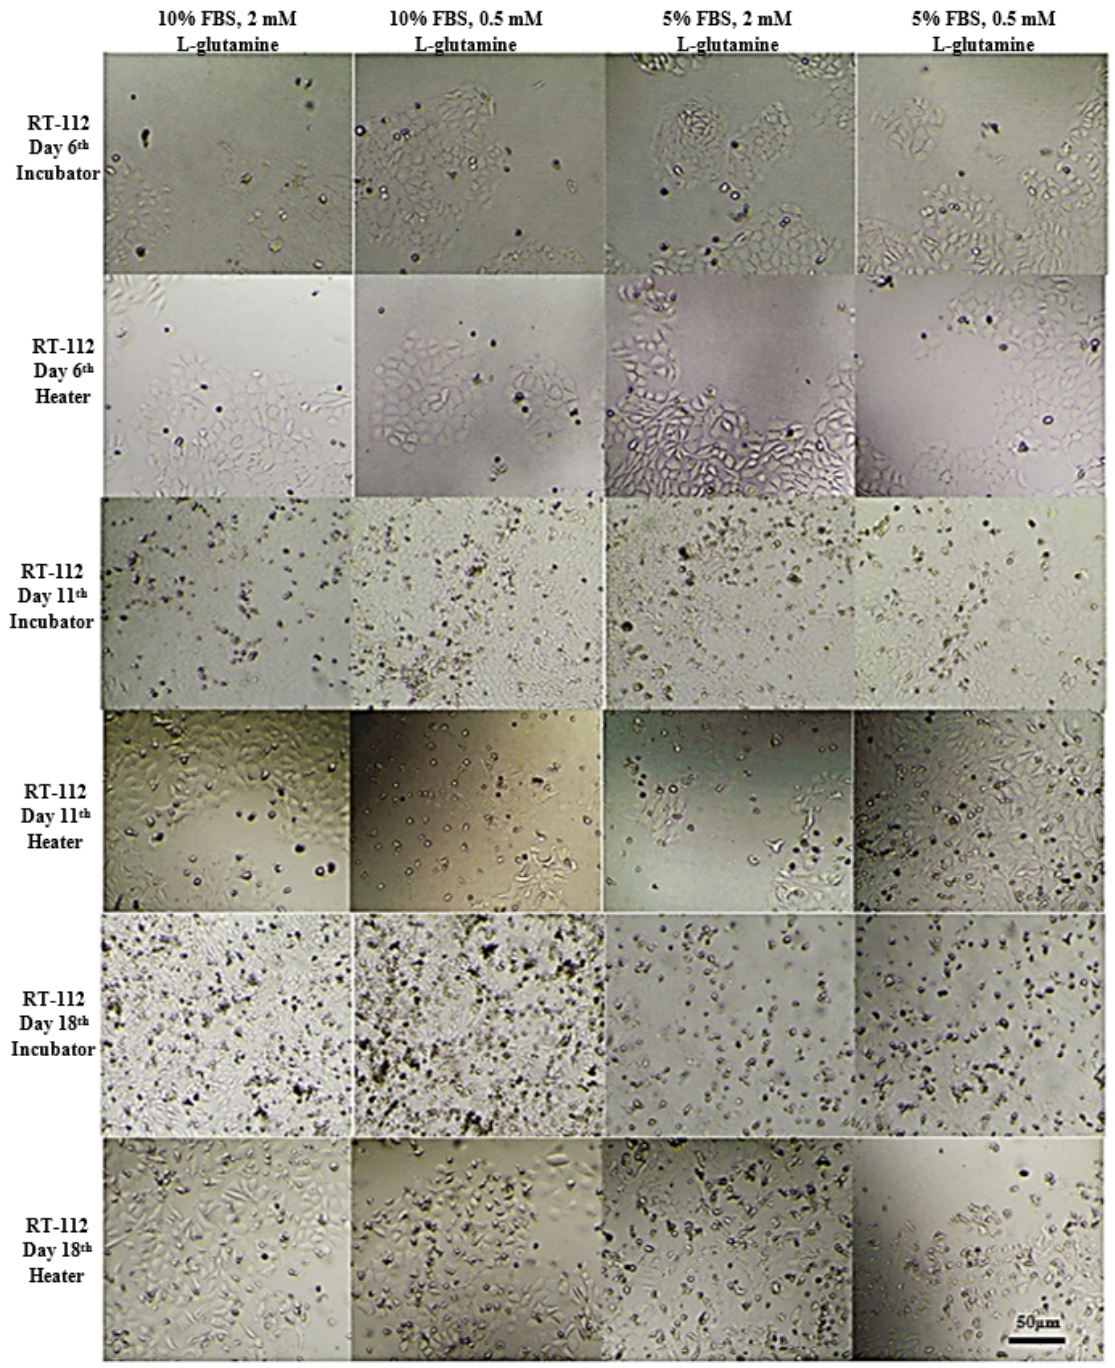
Figure 8. Representative images showing RT-112 cells morphology at given conditions after indicated days of incubation. Incubator 37 °C, 5% CO 2 (standard growth conditions); heater 37 °C.